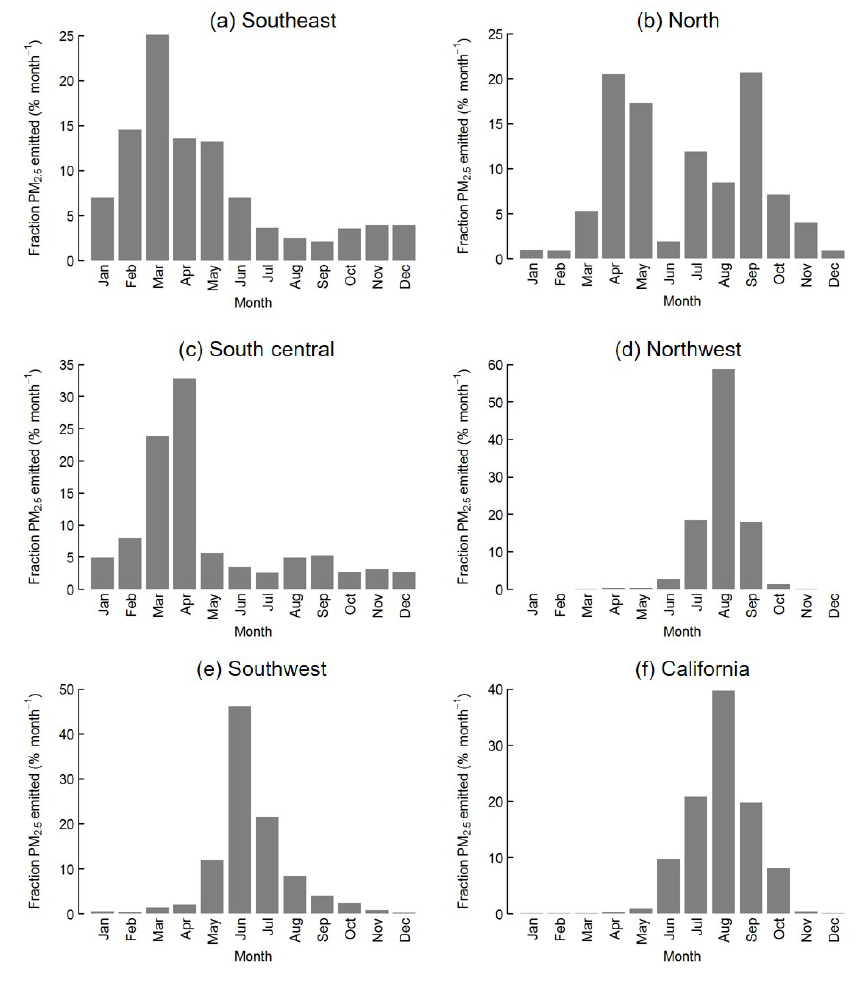
Figure 15. Monthly PM 2 . 5 emitted averaged over 2003–2015.